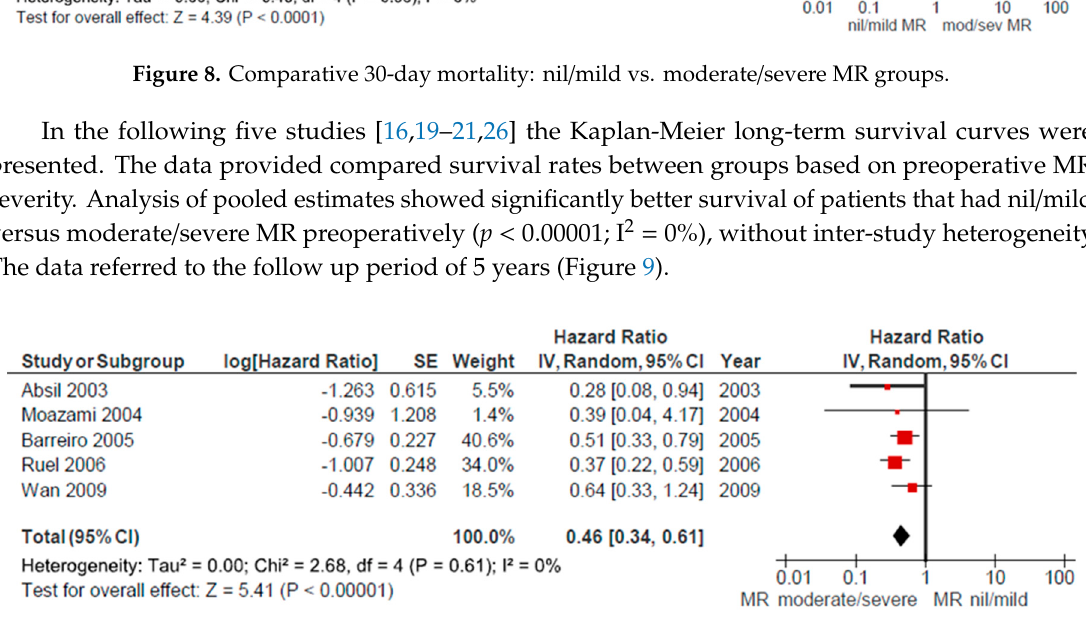
/ mild vs. moderate / severe MR Figure 9. 5-year survival comparison: nil/mild vs. moderate/severe MR groups. Figure 9. 5-year survival comparison: nil Figure 9. 5-year survival comparison: nil/mild vs. moderate/severe MR groups.